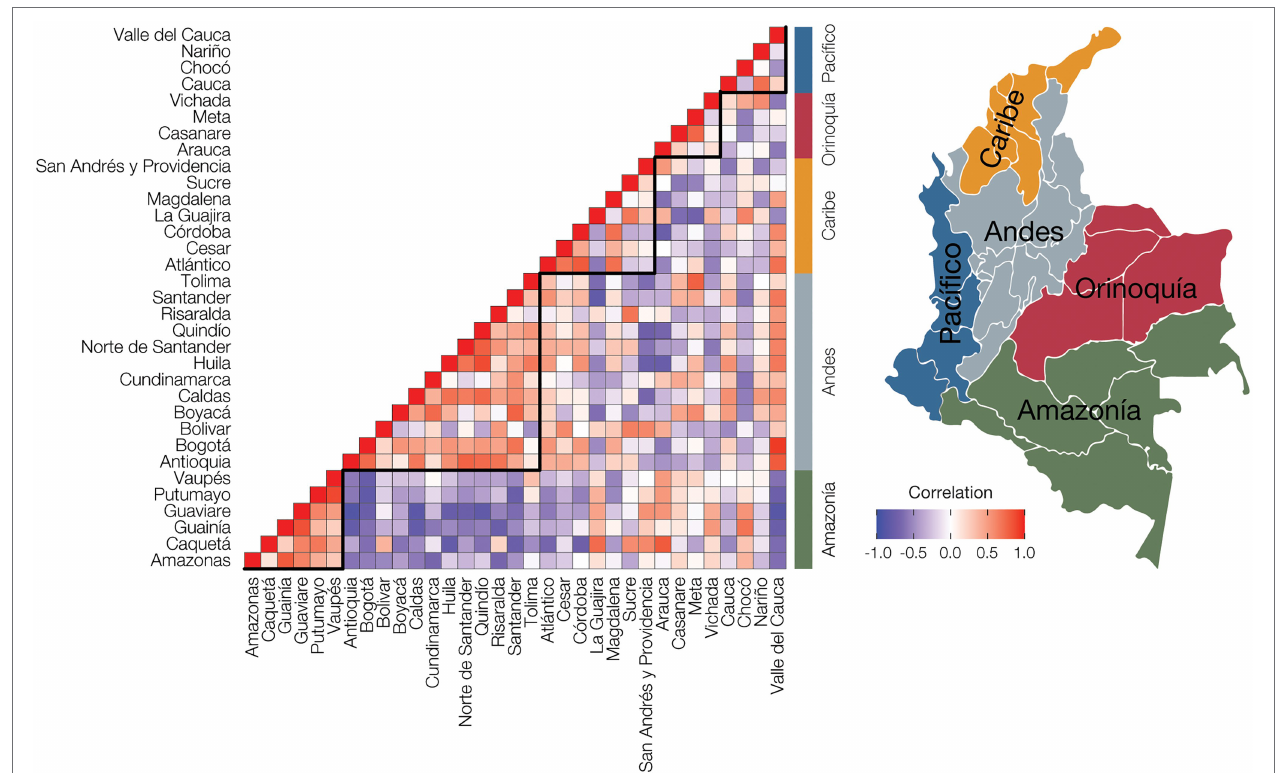
FIGURE 4 | Population comorbidity and geography. Disease prevalence values were normalized for each administrative department by dividing the observed prevalence value for each disease with the maximum disease prevalence value for the department to yield relative disease prevalence values. The relative disease prevalence values were correlated between all pairs of departments to infer overall comorbidity levels, i.e., similar relative disease prevalence values, among departments and geographic regions. Positive disease prevalence correlations between departments are shown in red, and negative correlations are shown in purple. Administrative department names are shown to the left of the plot, and geographic region names are shown to the right of the plot, with locations indicated on the adjacent